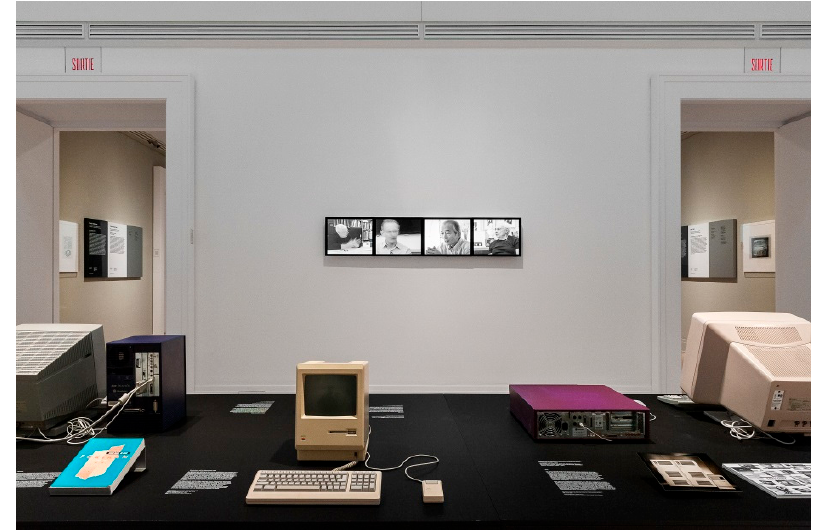
Figure 3. Archaeology of the Digital, installation view with video interviews of Peter Eisenman, Chuck Hoberman, Shoei Yoh, and Frank Gehry on the wall and samples of hardware in front, Canadian Centre for Architecture, 2013. Photograph: © CCA.